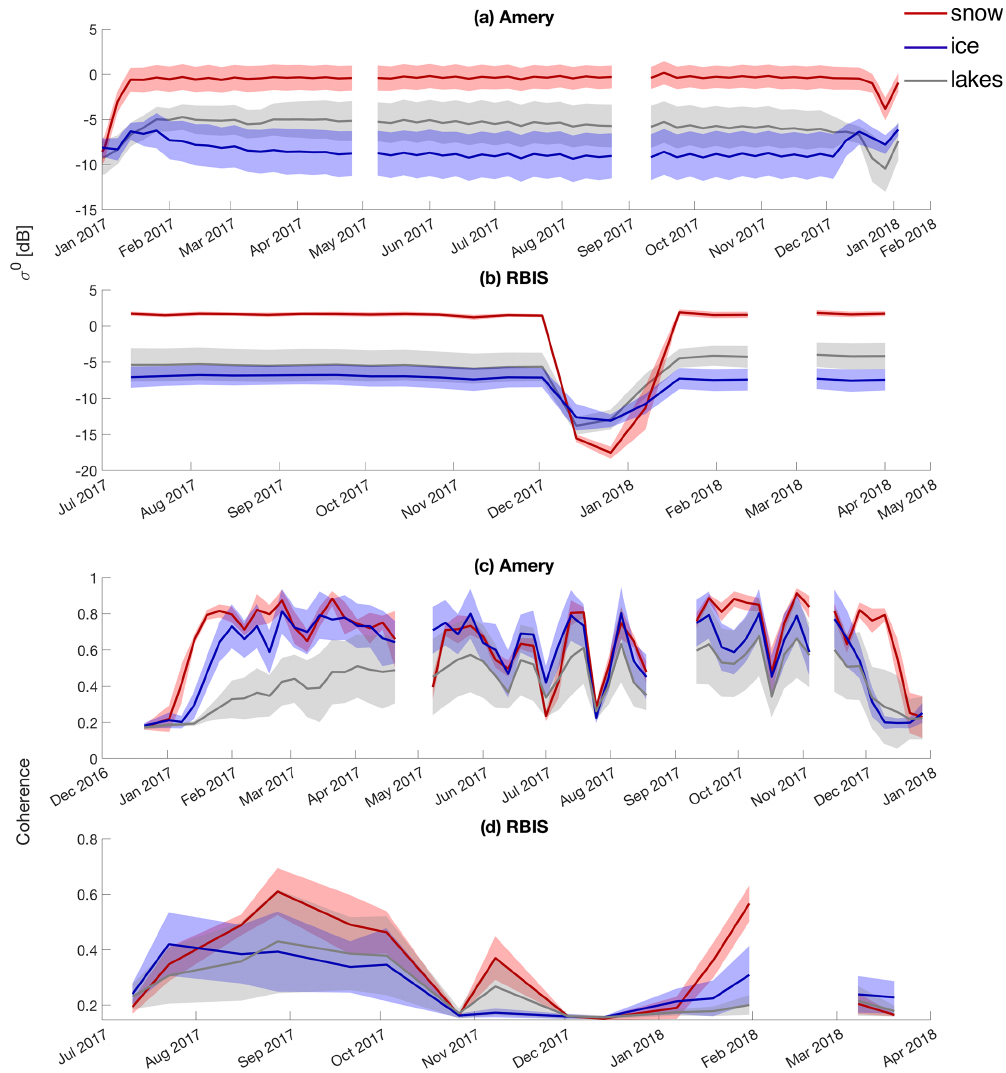
Figure 3. Time series of mean (solid line) and standard deviation (semi-transparent area) of σ 0 and coherence over Amery and Roi Baudouin ice shelves (see Fig. 1 for locations). Mean and standard deviation are calculated from all features indicated in Fig. 1. Times with a lack of 6 and 12d revisit frequency are masked, resulting in